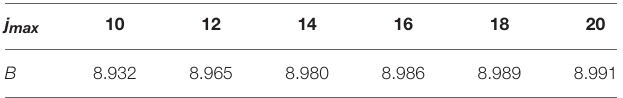
m p , G max 60, N max 24 ,and γ 4 fm − 1 . = = = =